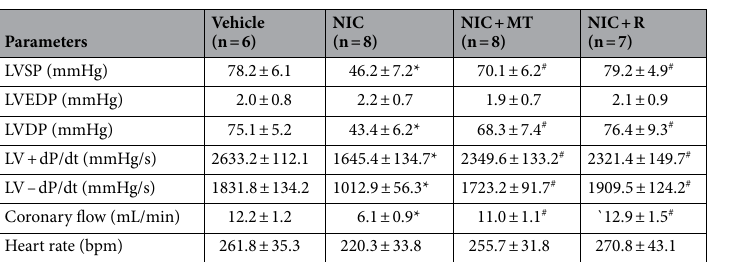
(Fig. 4C,D). Although mitoTEMPO showed a trend for reduction in ANXA1 and FPR2, no statistical signifi- cance was attained. MitoTEMPO and resveratrol attenuated nicotine‑induced cardiac dysfunction in rats. (Table 2). Markers of LV function (LVSP, LVDP, LV + dP/dt, and LV − dP/dt) were all significantly reduced in nicotine-administered rats, as compared to the vehicle controls ( p < 0.05; Table 2), indicative of cardiac dysfunc- tion. Nicotine administration also markedly impaired baseline coronary flow rate in these hearts compared to the vehicle controls ( p < 0.05; Table 2). However, mitoTEMPO and resveratrol significantly attenuated nicotine- induced reduction in LVSP, LVDP, LV + dP/dt, LV − dP/dt, and coronary flow rate ( p < 0.05; Table 2), thus pre-